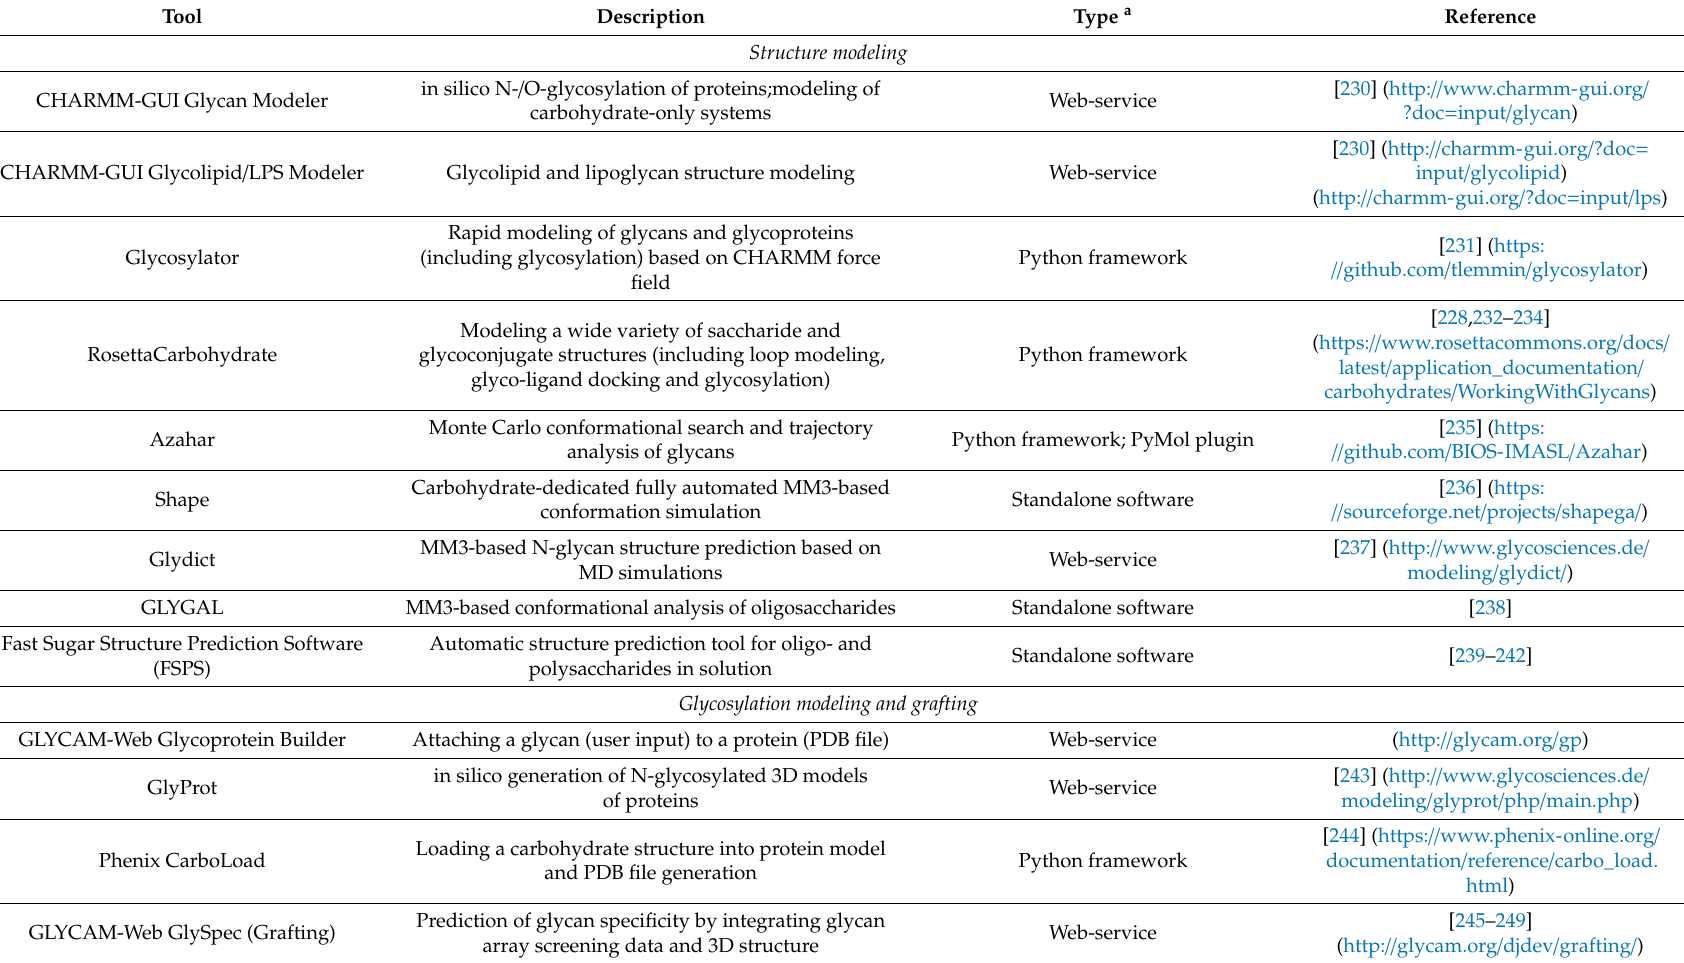
Table 2. Informatics tools for carbohydrate and glycoprotein modeling, 3D structure prediction and